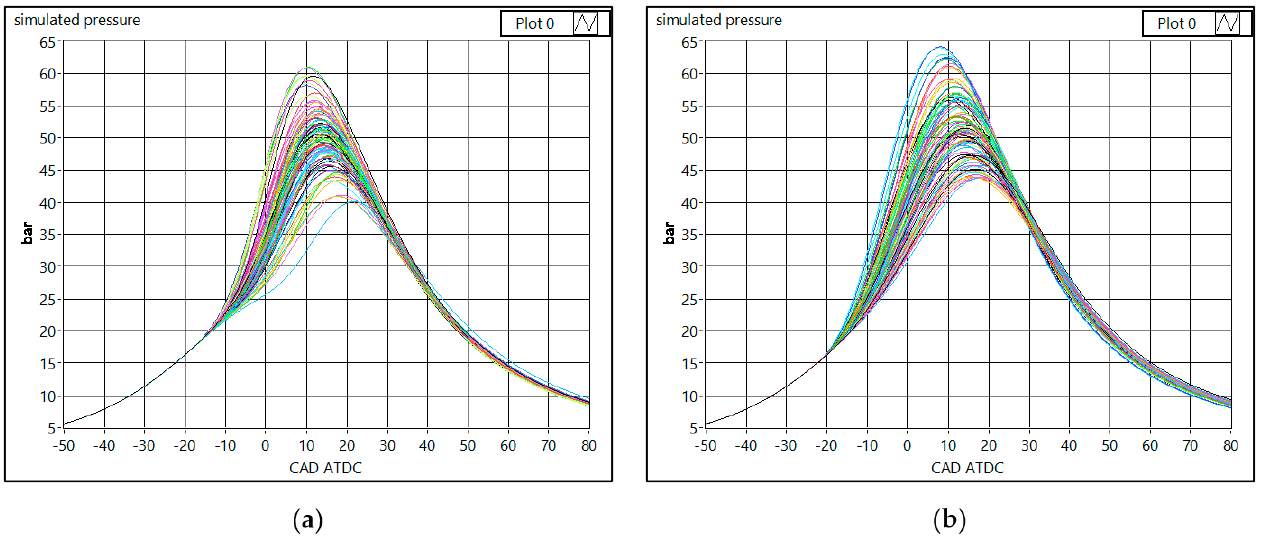
Figure 15. 100 simulated pressure cycles; MAP = 1 bar, engine speed n = 3500 rpm, fuel 100% NG. ( a ) using the Hill function; ( b ) using the Wiebe function. Figure 16a,b show the numeric IMEP distribution obtained with the Hill and Wiebe equations, respectively; both the mean IMEP and SD are quite similar to the experimental values revealing an equivalent ability of both models to simulate the engine cyclic variation (the numeric results are displayed in the figures caption and resumed in Table